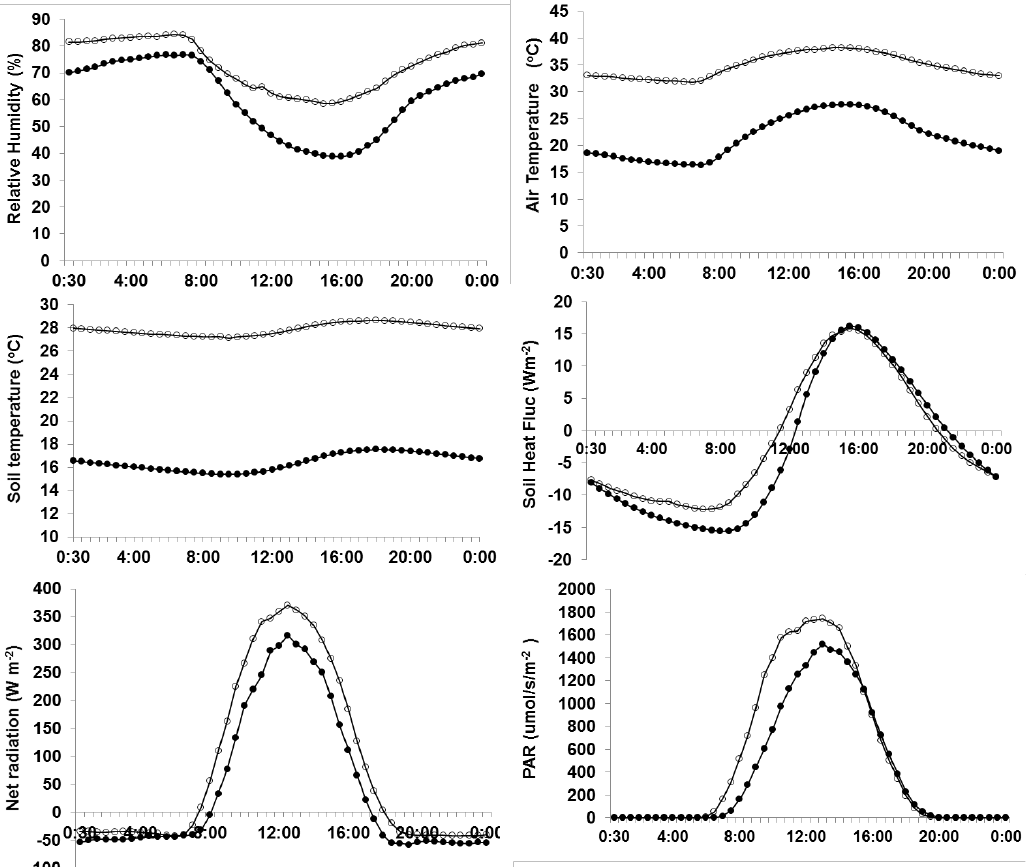
Figure 5. Average diurnal pattern of relative humidity (RH), air temperature (AT), soil temperature (ST), soil heat flux (SHF), net radiation (NR)and PAR in rice (empty circle) and wheat (filled circle).